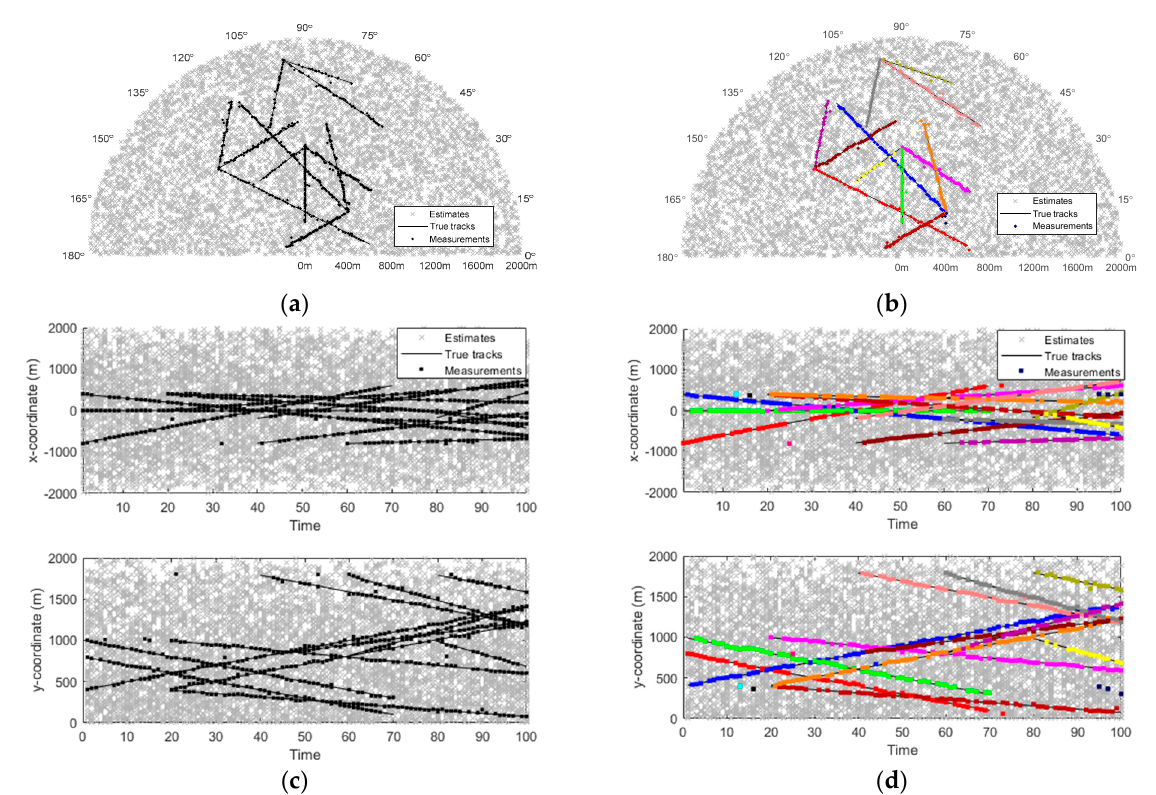
Figure 6. The estimations of the multi-target trajectories and the actual measurements in example 1 (CV motion model) for a sample run. ( a ) The actual measurements, actual trajectories and estimated trajectories obtained after filtering by the SM-GM-PHD filter for T s = 1 s ( T i = 2 ms, λ = 104, p D , k = 0.8). ( b ) The actual measurements, actual trajectories and estimated trajectories obtained after filtering by the SM-LGM-PHD filter for T s = 1 s, and the different trajectories are denoted by different color dots. ( c ) The actual measurements, actual trajectories and estimated trajectories obtained after filtering by the SM-GM-PHD filter in x and y coordinates for T s = 1 s. ( d ) The actual measurements, actual trajectories and estimated trajectories obtained after filtering by the SM-LGM-PHD filter in x and y coordinates for T s = 1